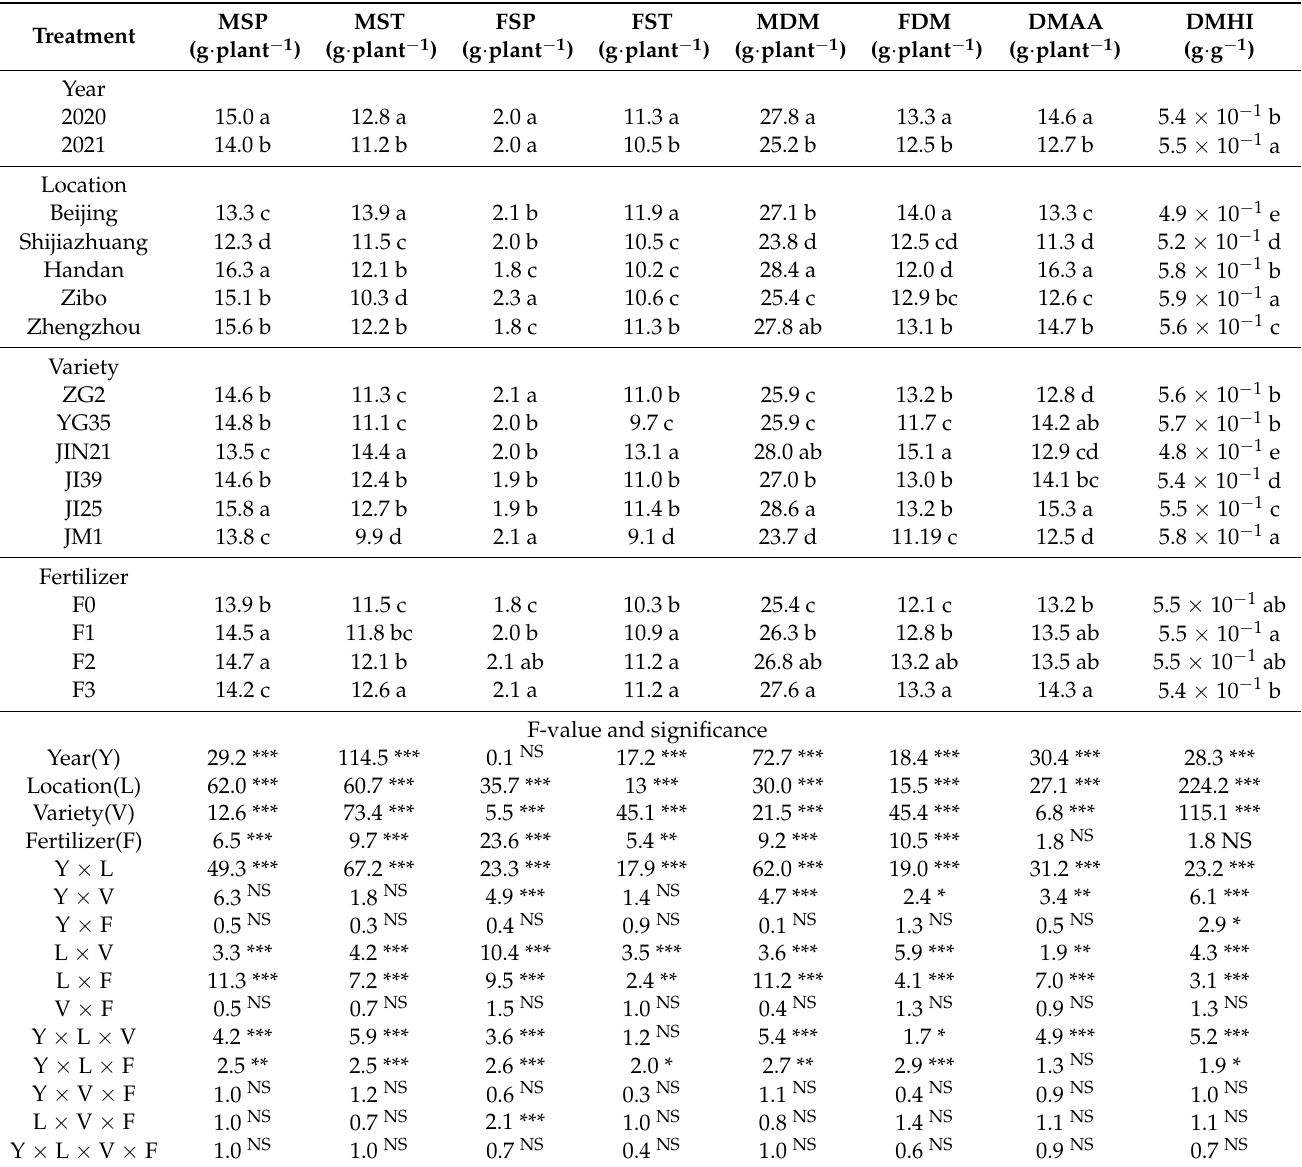
Table 4. Interaction effect of year, location, variety and fertilization on agronomic traits of foxtail